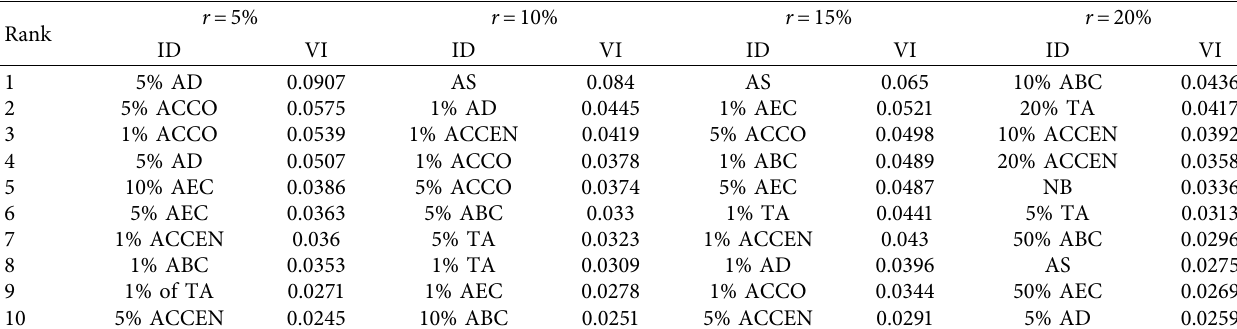
Figure 9: Impact of the topology of networks on the capital reserves ratio. Different attack scenarios and the key parameters of the network topology when β � 1, 2, 4, 6, 8, 10, 15, 20, 30, and 50. Table 3: Ranking of features for each of the capital reserves ratios r